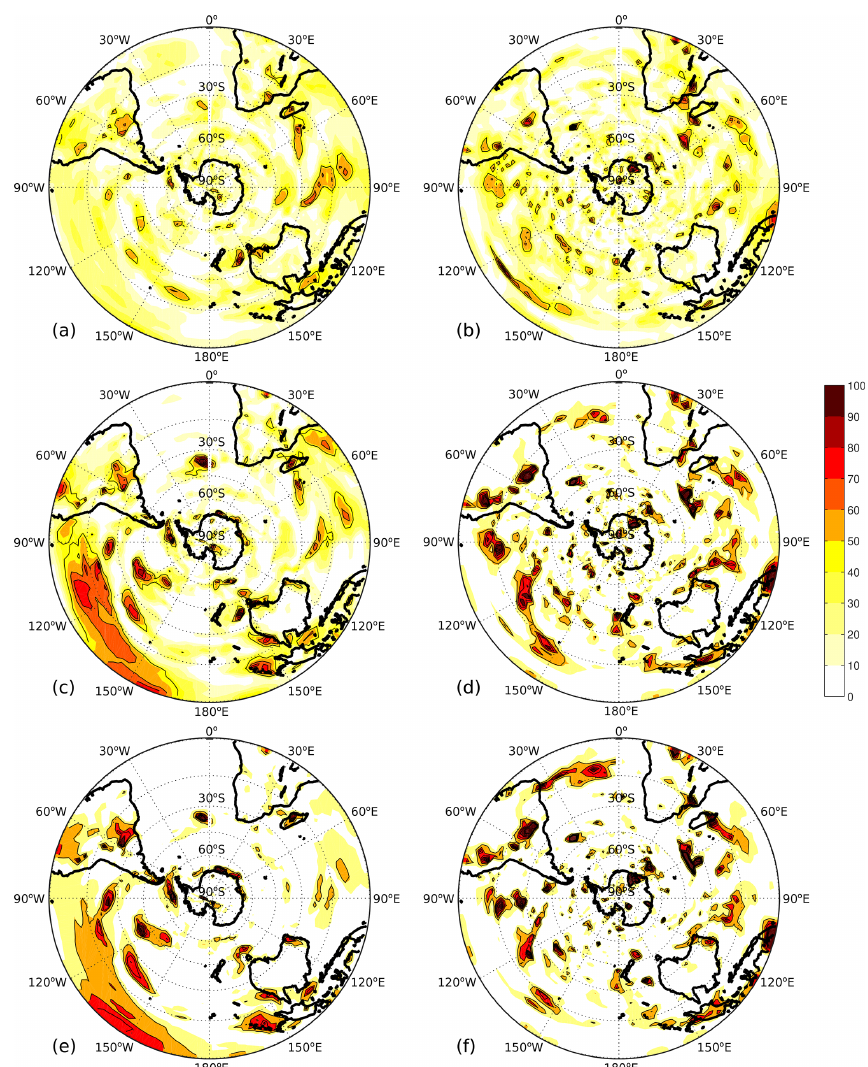
Figure 6. Number of years at each grid point where the 31 year (a, b) , 61 year (c, d) , and 91 year (e, f) running correlation between SAT (a, c, e) or precipitation (b, d, f) and the model SAM falls outside the 95% stationarity confidence interval (Sect. 2.2). As per our definition of non-stationarity, regions which fall outside this interval 10% of the time or more ( ≥ 47, 44, and 41 years for the 31, 61, and 91 windows, respectively) are highlighted with solid black contours and are considered to be